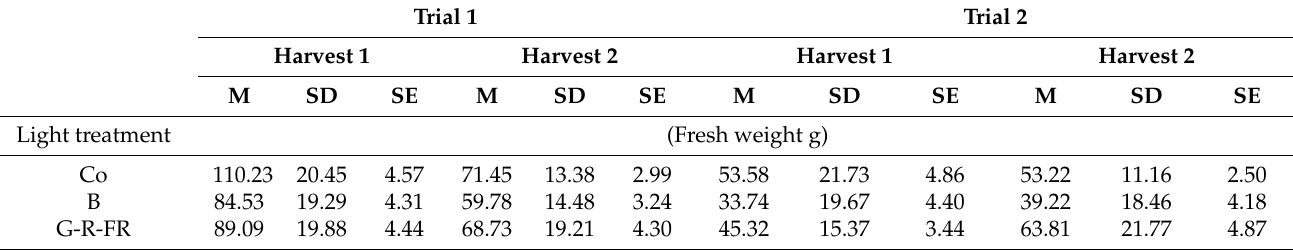
Table 1. Tenderstem ® fresh shoot weight (g) mean and standard deviation at each harvest.